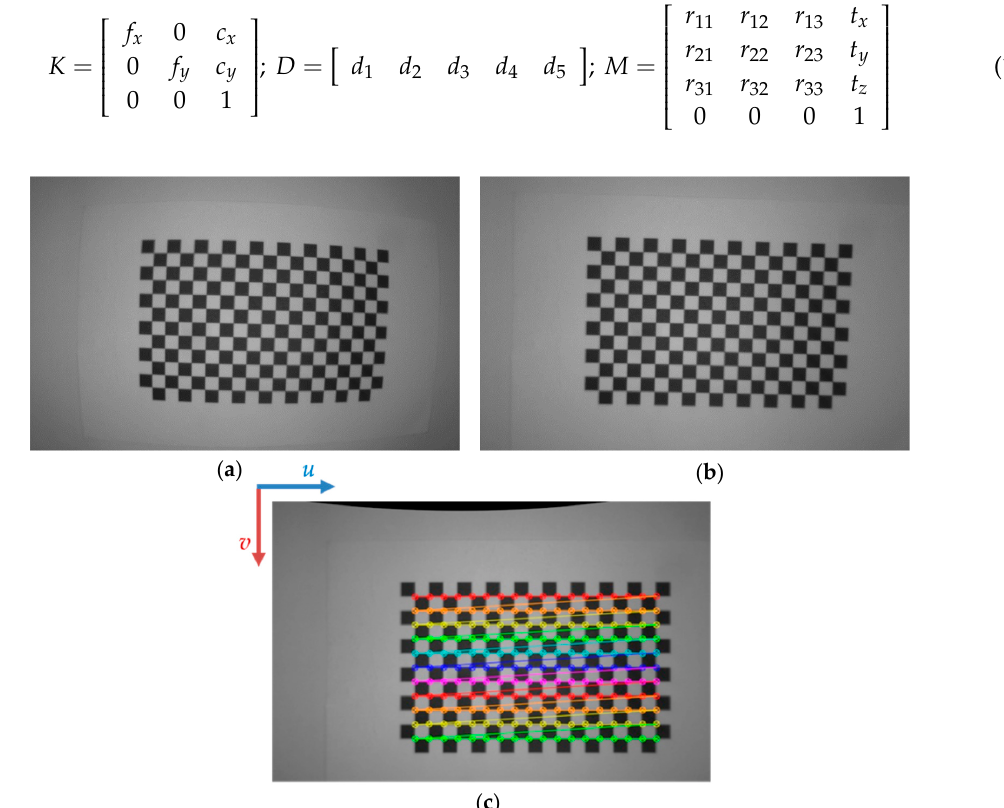
Figure 3. Calibration pattern placed on the ground floor before ( a ) and after ( b ) the rectification step. The camera pose compensation of rectified image ( b ) is evident in ( c ) as it leads the chessboard corners to be well aligned with the horizontal u- and vertical v- directions of the image under investigation.